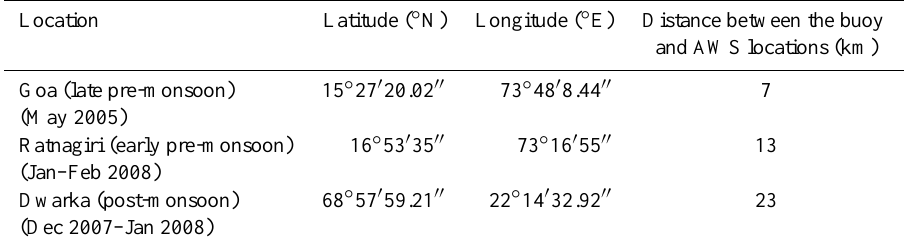
Table 1b. Details of AWS wind